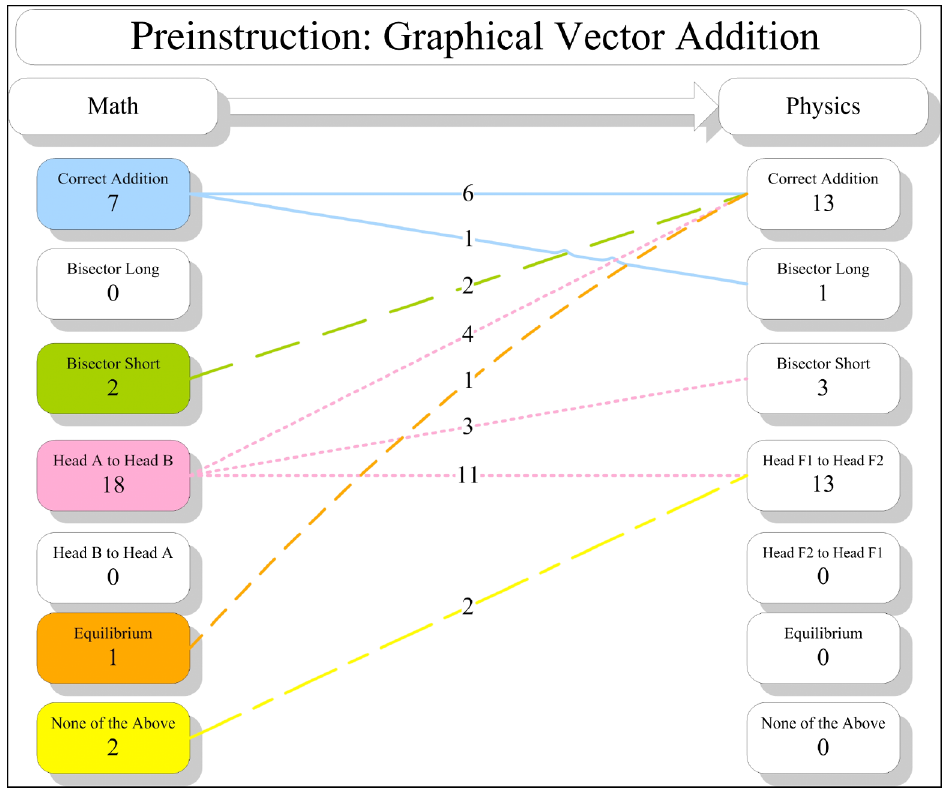
FIG. 2. Expanded escalator plot. By including all categories of partially incorrect responses (most egregious at the bottom), we gain more understanding of student responses on nearly identical questions (see Ref. [12] for more details).